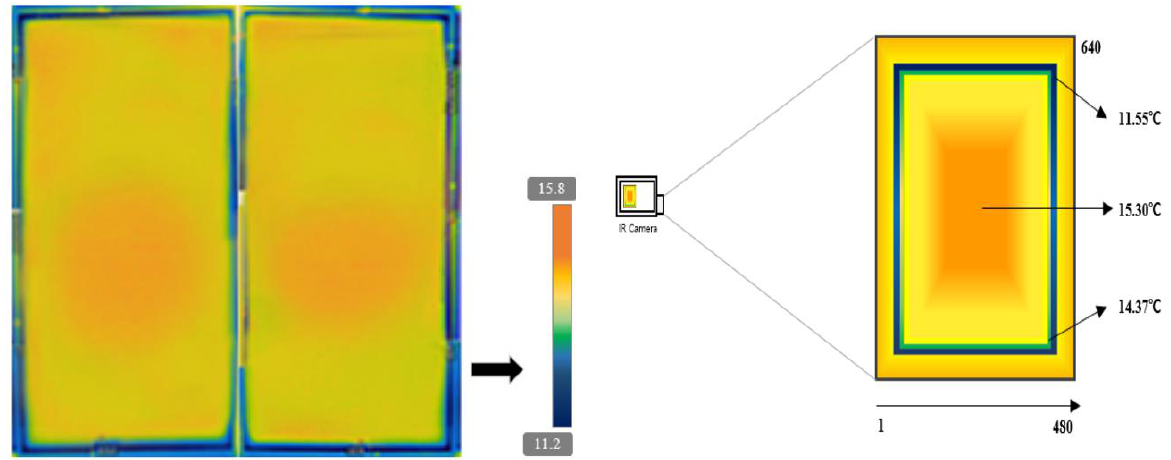
Figure 13. Window surface temperatures using an IR camera [11].